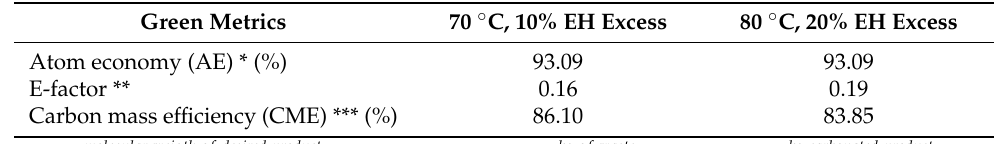
Table 3. Green metrics for the biocatalytic synthesis of EHMH at 70 ◦ C, 10% EH excess and at 80 ◦ C, 20% EH excess; 350 rpm, 2.5% ( w/w )